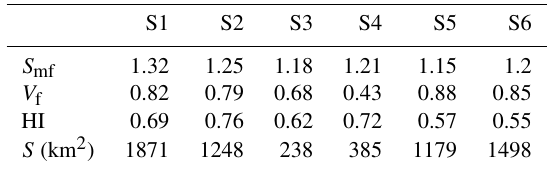
Table 1. Geomorphic indices and catchment size ( S ) for the six main drainages basins (S1 to